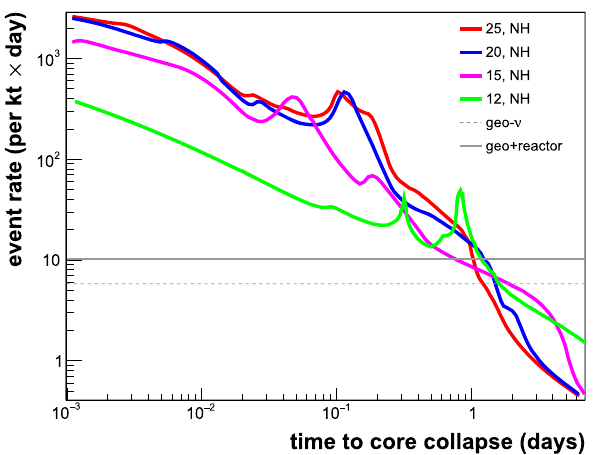
Fig. 13 Time-dependent pre-Supernova neutrino events expected in Theia-100: in total, more than 100 events are expected for a heavy- mass progenitor (25 M (cid:5) ) at 1kpc distance and NH. In all cases, the ¯ ν e event rate exceeds the relatively low background from geo- and reactor neutrinos ∼ 1daybeforetheonsetofthecore-collapse.ForIH,expected